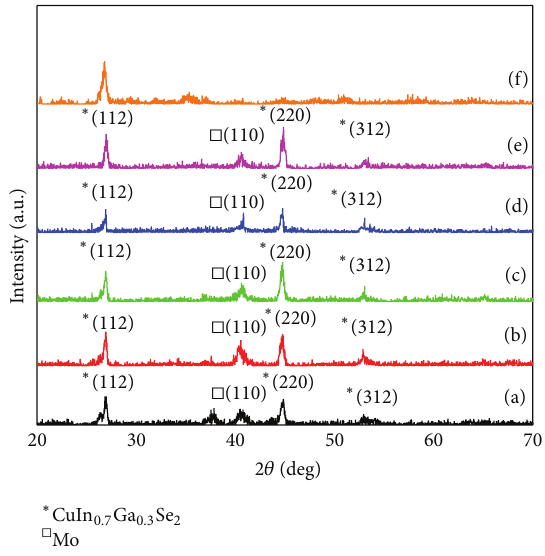
Figure 4: XRD pattern of thin films deposited under potentials (a) − 950 mV, (b) − 1150mV, (c) − 1350 mV, (d) − 1550 mV, (e) − 1750 mV, and (f) − 1950